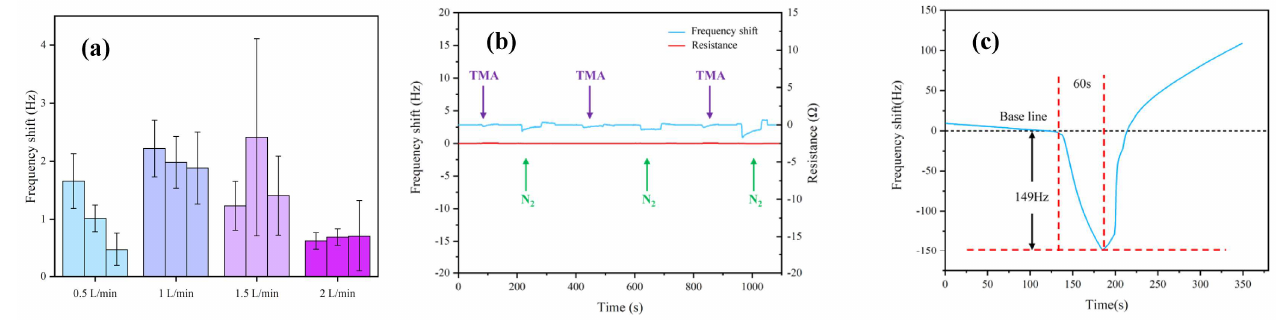
Figure 3. Dynamic responses of QCM sensor to gas vapors. ( a ) Influence of different nitrogen flow rates on the QCM sensor, ( b ) the bare QCM sensor to TMA, and ( c ) the GO-based QCM sensor to TMA and nitrogen.